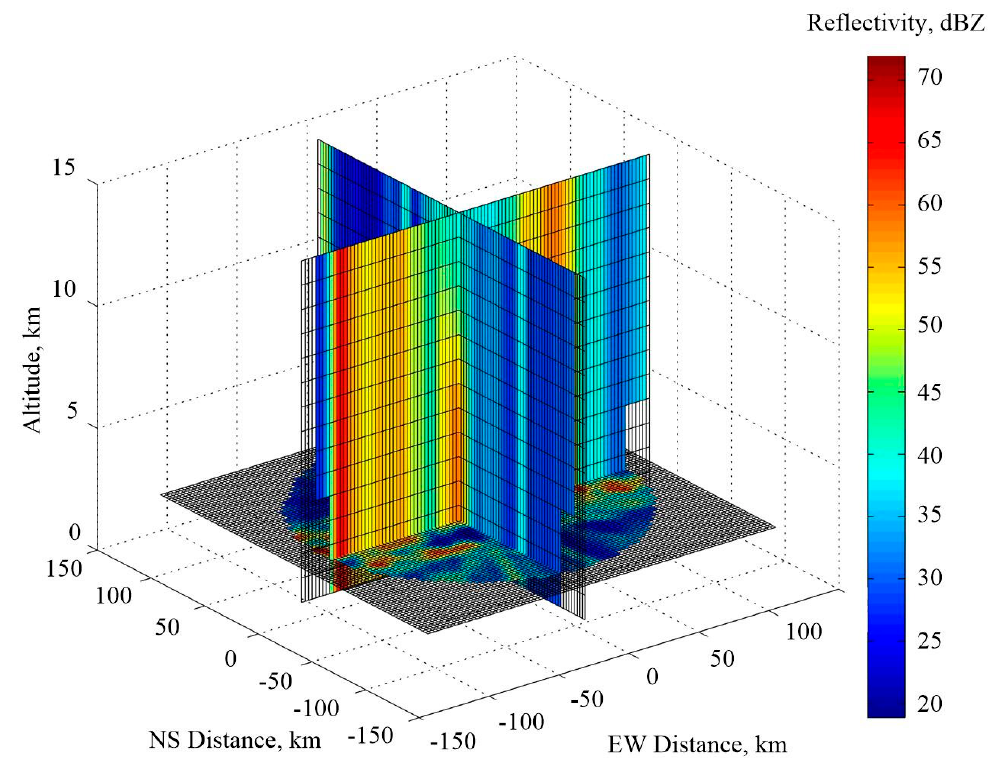
Figure 16. Slicing cross-sections of the thundercloud volumetric Doppler radar reflectivity through the computed positive lightning leader onset, which is relevant to Case #4. Slicing cross-section planes are forward through the point indicated by coordinates: x = − 11.9 km, y = − 6.9 km, z = 2 km.